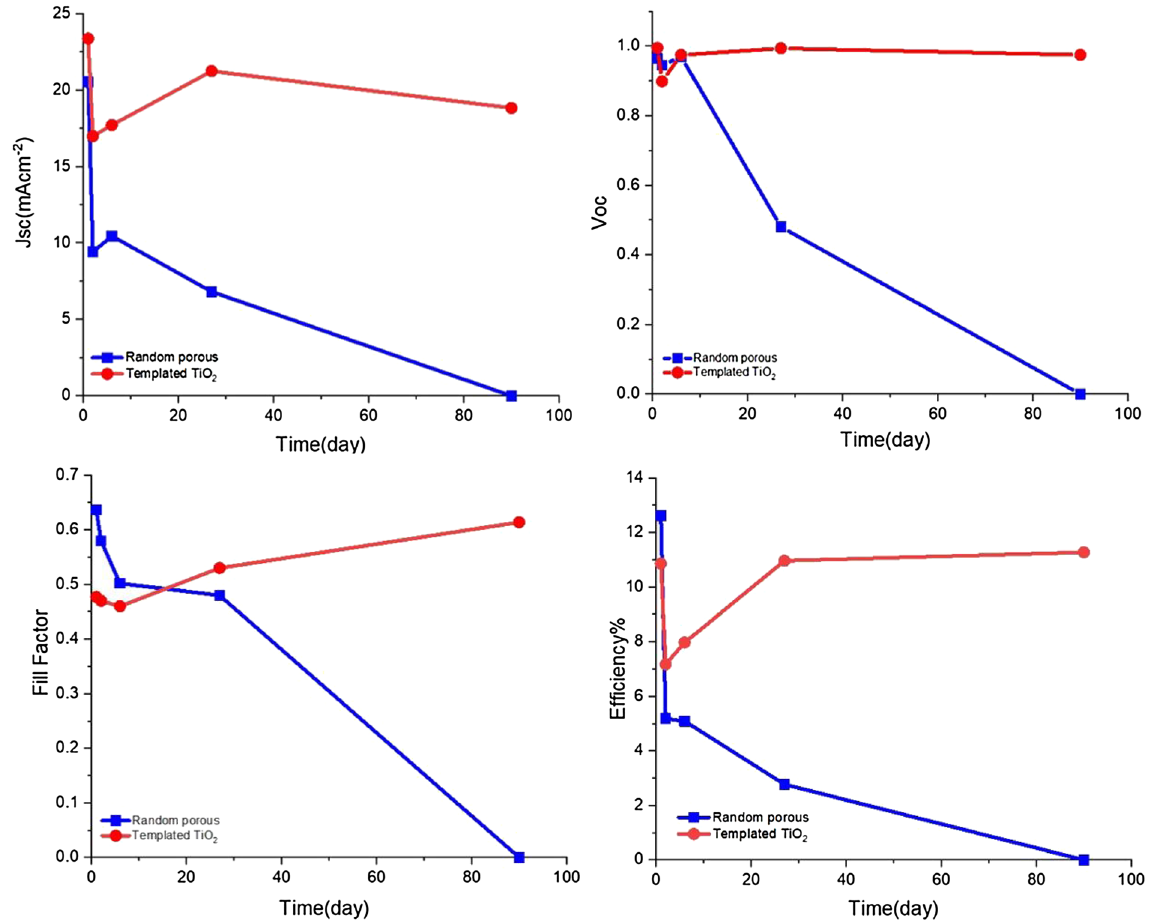
Figure 6. Stability of photovoltaic parameters of standard and templated TiO 2 -based CIS-PSCs measured during 90 days under ambient conditions (25–30 °C, relative humidity of 30–45%). Evolution of J sc , V oc , FF, and